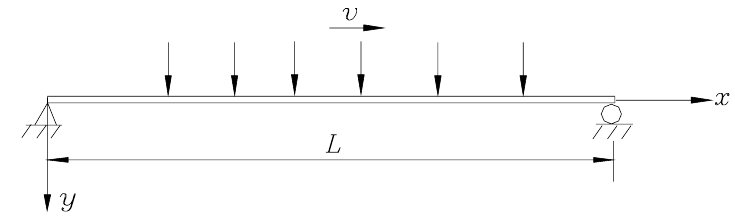
Fig. 1. A simply supported Timoshenko beam subjected to a series of moving concentrated forces.